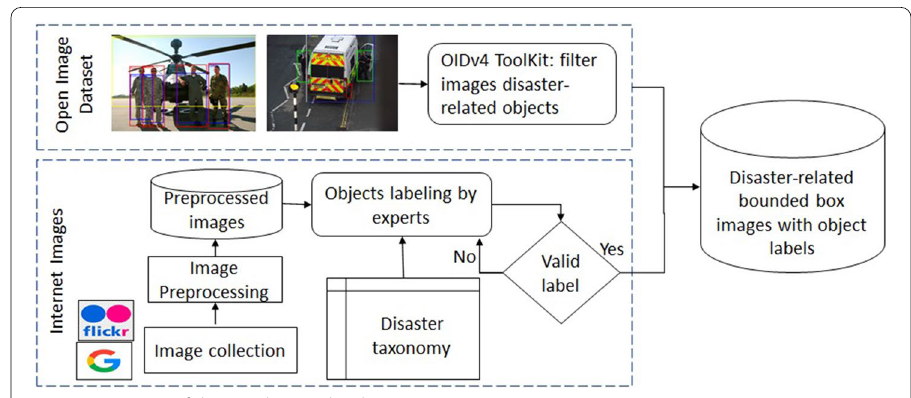
Fig. 2 Main steps of disaster dataset